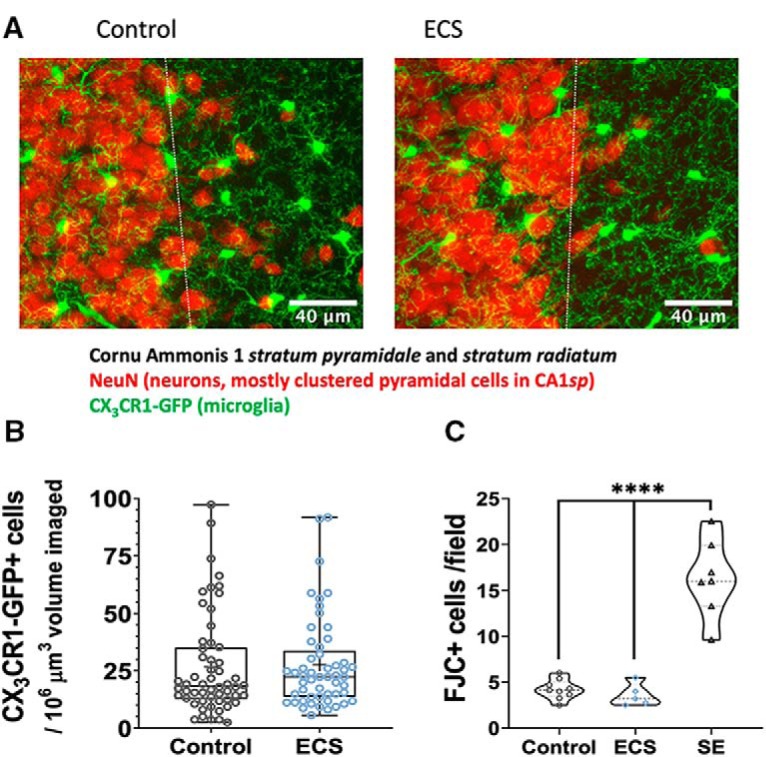

ECS did not affect density of microglia and did not cause neuronal degeneration in mouse CA1 24 h after seizures. A, Representative MIPs from immunofluorescence image showing CX3CR1-GFP+ microglia in green and NeuN+ neurons in red in CA1 (stratum pyramidale = left of dashed line; stratum radiatum = right of dashed line) of control (top) and ECS (bottom) mice 24 h after seizures. B, Density of microglia in CA1sr microglia per 106 μm3 of CA1sr volume. Control animals had 26.69 ± 2.9 which was not significantly different from ECS animals that had 27.59 ± 2.7. C, Number of FJC-positive cells per field imaged (320 × 240 μm). Control and ECS-exposed animals have significantly lower degenerating cell densities in CA1 than SE-exposed animals: 4.2 ± 0.36 for controls (N = 9) and 3.6 ± 0.54 for ECS animals (N = 5), compared to 16.3 ± 1.5 for SE animals (N = 7). ****p < 0.0001.